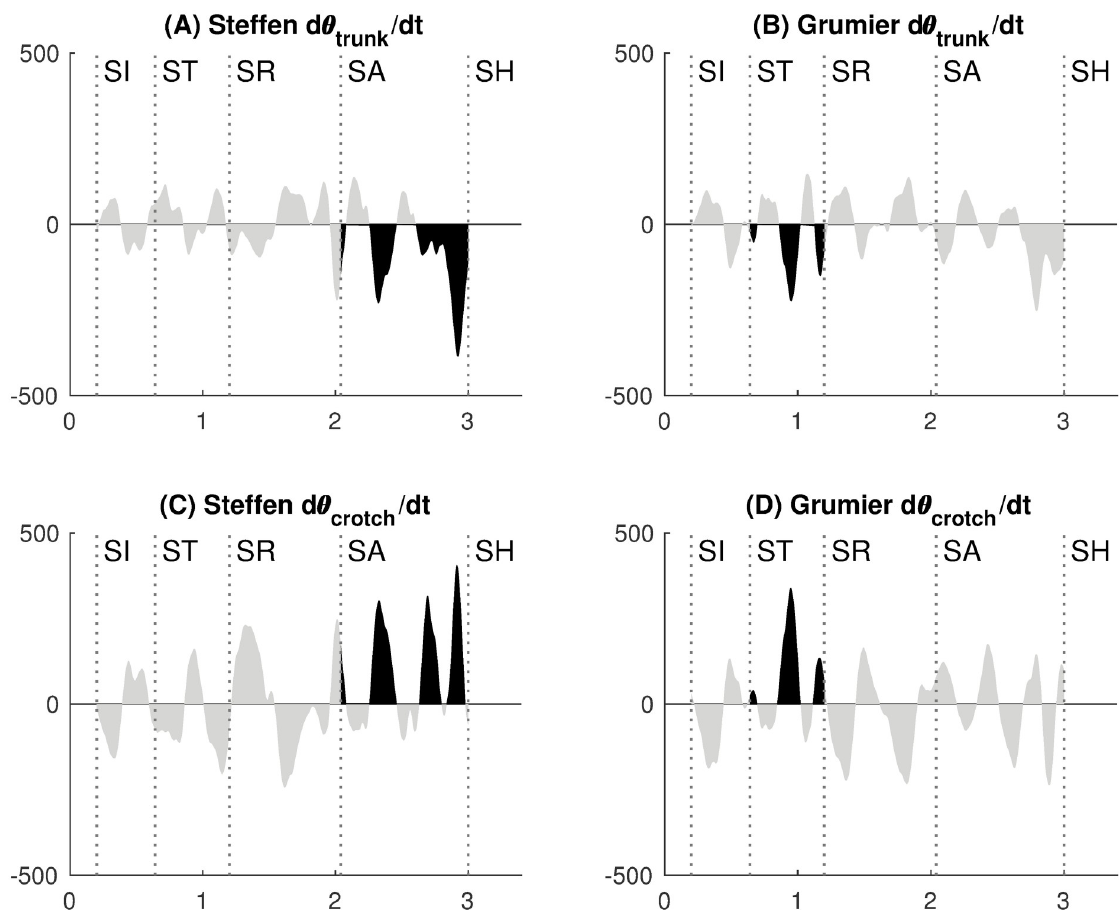
Fig 14. Trunk and crotch angular velocities. (A) Negative velocity peaks when closing the trunk during the Steffen’s attack. (B) Negative velocity peaks when closing the trunk during the Grumier’s threat. (C) Positive velocity peaks when opening the crotch during the Steffen’s attack. (D) Positive velocity peaks when opening the crotch during the Grumier’s